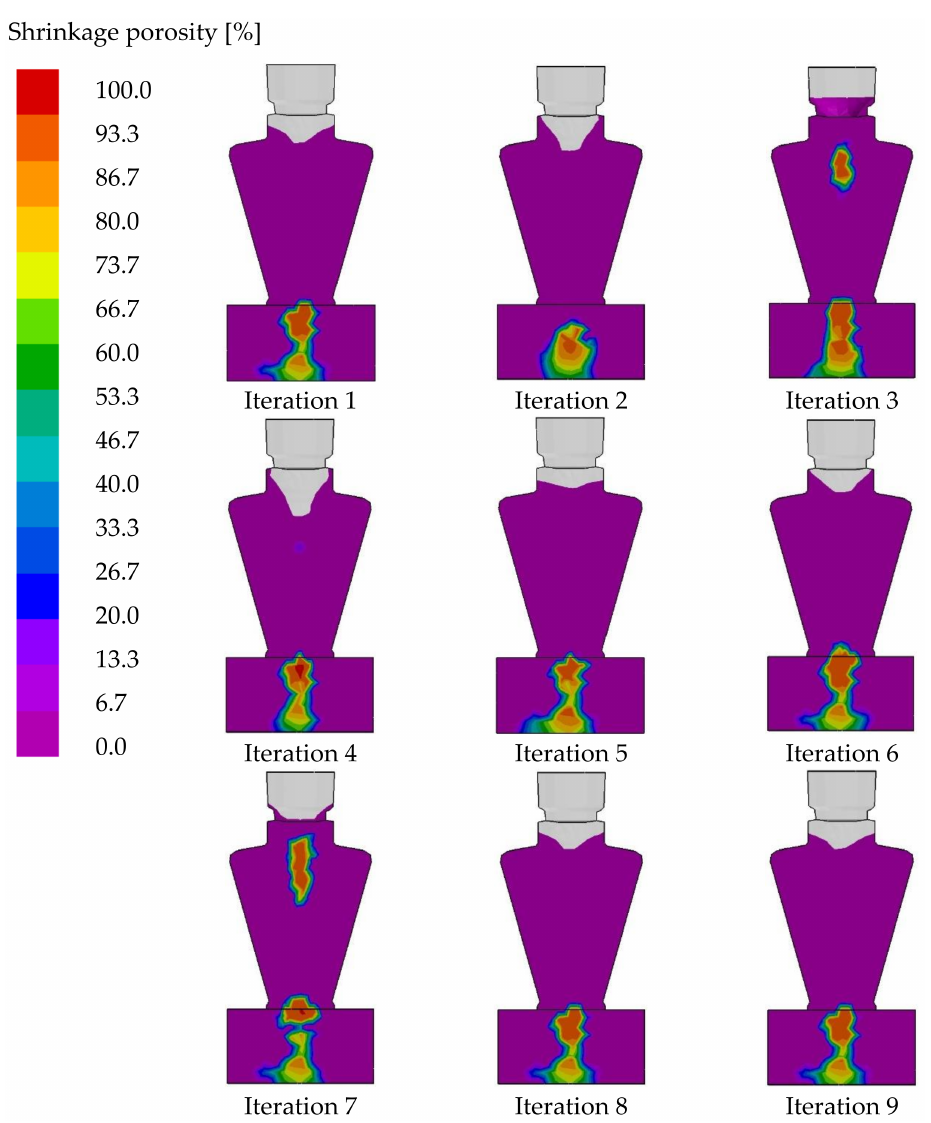
Figure 17. Shrinkage porosity prediction for both gating system and part for iteration 1 to